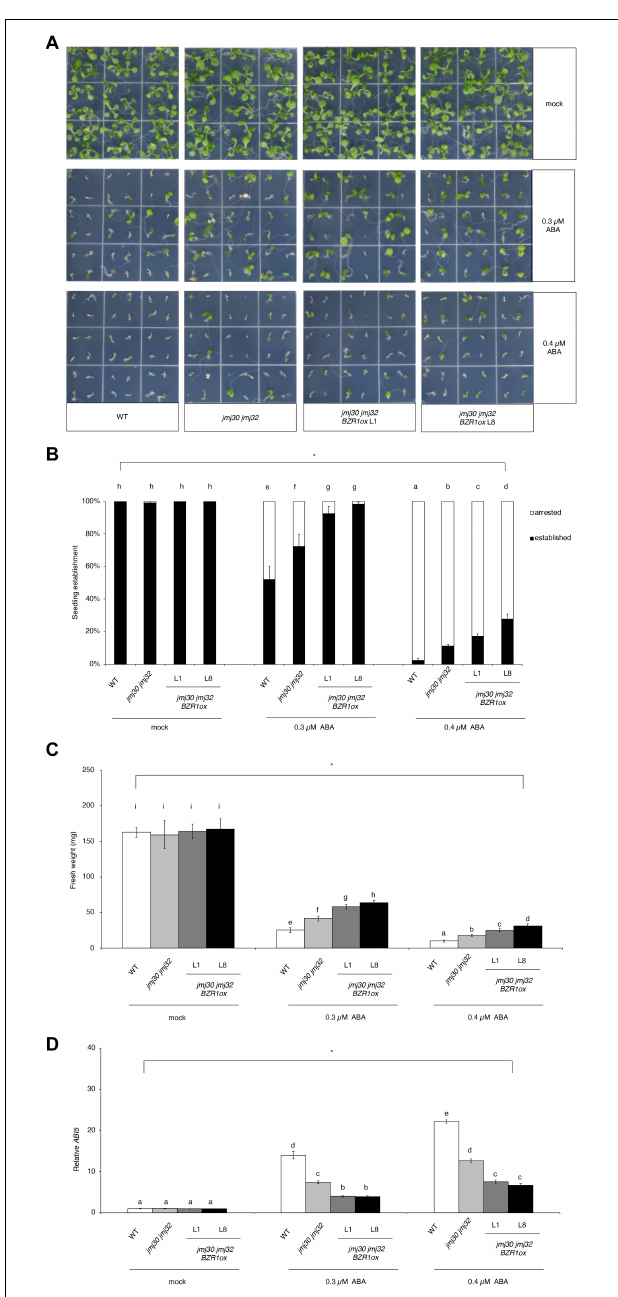
FIGURE 4 | Overexpression of BZR1 in jmj30 jmj32 attenuates ABA sensitivity. (A) Representative images of wild-type, jmj30-2 jmj32-1 , jmj30-2 jmj32-1 BZR1ox L1, and jmj30-2 jmj32-1 BZR1ox L8 seedlings grown for seven days on 1/2 MS medium (-sucrose) with 0, 0.3, or 0.4 µ M ABA. (B) Percentage of established and arrested seedlings in wild-type, jmj30-2 jmj32-1 , jmj30-2 jmj32-1 BZR1ox L1, and jmj30-2 jmj32-1 BZR1ox L8 plants in the absence and presence of ABA. Asterisks indicate significant differences based on one-way ANOVA test. p < 0.05. Different letters indicate significant differences based on a post hoc Tukey’s HSD test. p < 0.01. NS: non-significant. (C) Measurement of the fresh weight of wild-type, jmj30-2 jmj32-1 , jmj30-2 jmj32-1 BZR1ox L1, and jmj30-2 jmj32-1 BZR1ox L8 seedlings in the absence and presence of ABA. Asterisks indicate significant